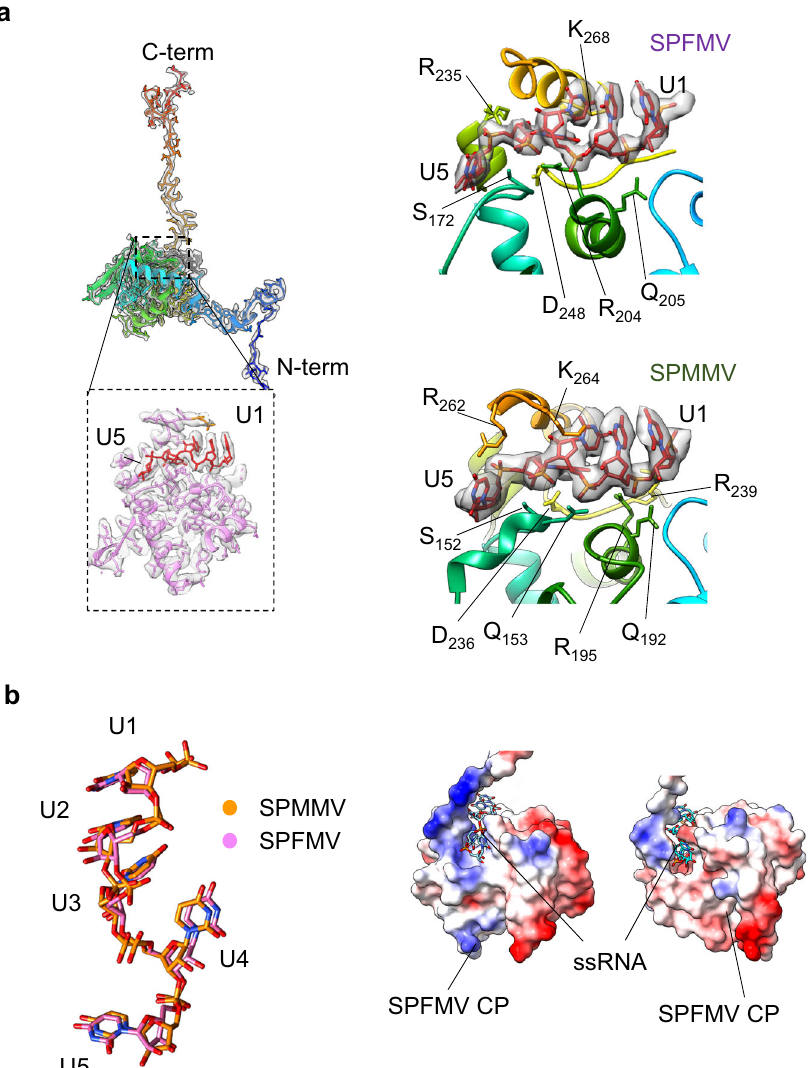
Fig. 6 ssRNA interactions. a Left panel shows fi tted atomic model of SPFMV CP, coloured from N- (blue) to C-termini (red) with cryoEM densities shown in grey. A zoomed-in panel shows the RNA binding cavity located within the core domain; SPFMV model shown in pink with RNA nucleotides U1 to U5 in red. Top right and bottom right panels show the RNA binding site in SPFMV and SPMMV respectively, with fi tted atomic coordinates for ssRNA (in red) inside cryoEM map (shown in grey). Key interacting residues are labelled. b Left panel shows the aligned structures of ssRNA from SPFMV (in pink) and SPMMV (in gold) with labelled nucleotides. Right panel shows the computed surface electrostatic potential maps for CPs, viewed along the RNA binding pockets, with the ssRNA shown as an atomic model in cyan. The colouring ranges between positively charged (blue), neutral (white) and negatively charged (red)